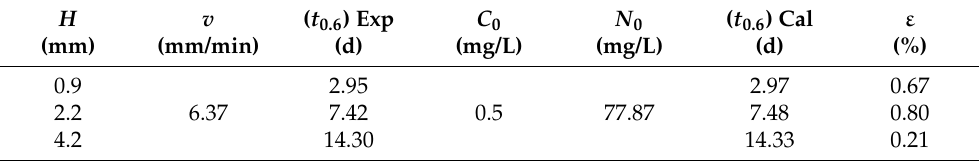
Table 4. Error of fitting parameters and penetration time of BDST